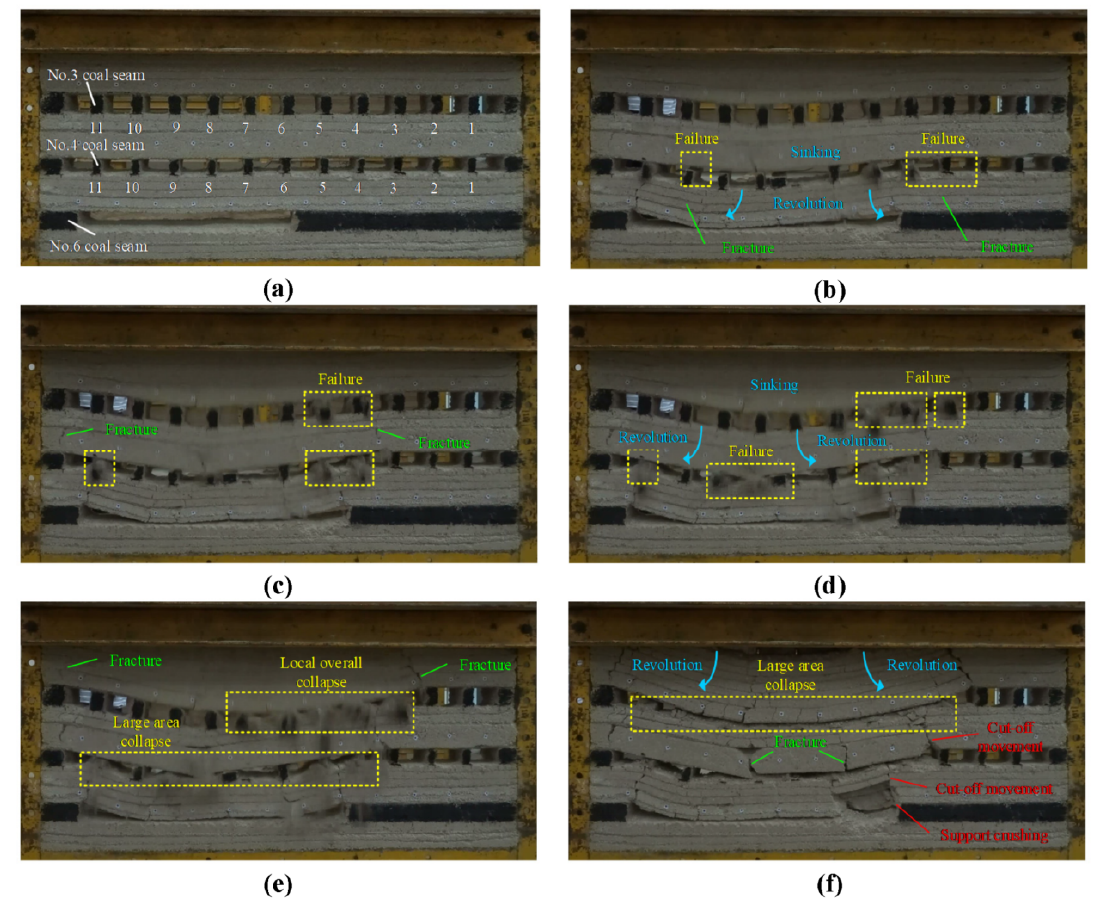
Figure 9. Dynamic collapse process of room-and-pillar mining pillars. ( a ) Before the coal pillar loses stability; ( b ) No.4, No.5, and No.11 coal pillars fail first; ( c ) No.4 and No.5 coal pillars fail successively; ( d ) No.8 and No.9 coal pillars fail; ( e ) Large area of coal pillar collapse; ( f ) Support crushing under strong ground pressure at longwall face.